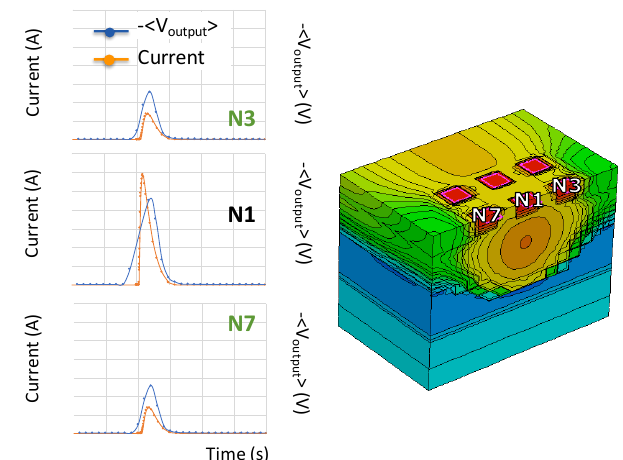
Fig. 6. Example of variation of the average output voltage of the VCO for three pixels related to the input current from the matrix, for an alpha particle generated